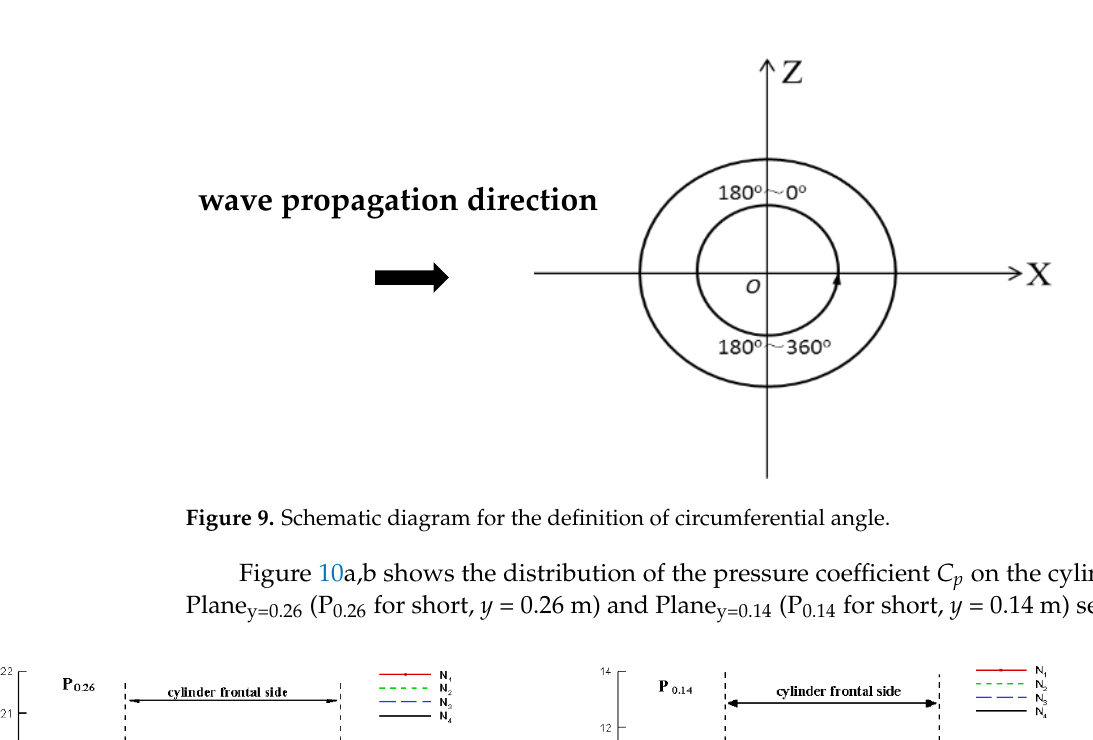
8 of 18 Figure 8. Comparison diagram of layered horizontal resultant force under four working conditions, C Fn = C Fn-max . 3.2. Comparison of the Vertical Distribution of the Force on the Cylinder in Different Cases The calculation results corresponding to the time C Fn = C Fn-max of all the cases (as shown in Figure 8, t ≈ 25 s, the time of the most unfavorable forces on the cylinder) are selected for analysis. By further analyzing the stress mechanism of the cylinder over different ter- rains, the cylinder body is divided into ten parts along the vertical direction, and a section is taken at a separation of 0.02 m. The parts in the upper layer are defined as “upper parts”, and the parts in the lower layer are called “lower parts”. The pycnocline between the up- per parts and lower parts is at the depth of 0.225 m. The vertical distribution of the non- dimensional horizontal forces C f at various water depths in all the cases are shown in Fig- ure 8. The calculation expression of C f is similar to Equation (8) for C Fn . C f on the upper parts of the cylinder is positive, and the value in case N 1 condition is significantly greater than that in the other three cases. C f on the lower parts of the cylinder becomes negative and the values in cases N 2 , N 3 , and N 4 are much greater than that in case N 1 . The pressure coefficient of the cylinder periphery at a certain depth section is Py C , and the expression can be defined as follows: 𝐶 𝑃𝑦 = 2 × （ 𝑃 𝑦 − 𝑃 𝑜𝑦 ） 𝜌 𝑦 𝑈 max𝑦2 (9) where P and U max are the point pressure on the cylinder periphery and the maximum ve- locity, respectively; P o is the point hydrostatic pressure on the cylinder periphery; and ρ is the fluid density. The subscript y denotes a certain depth y . In this paper, the values of y are 0.26 m and 0.14 m, which are the center heights of the upper and lower layers, re-